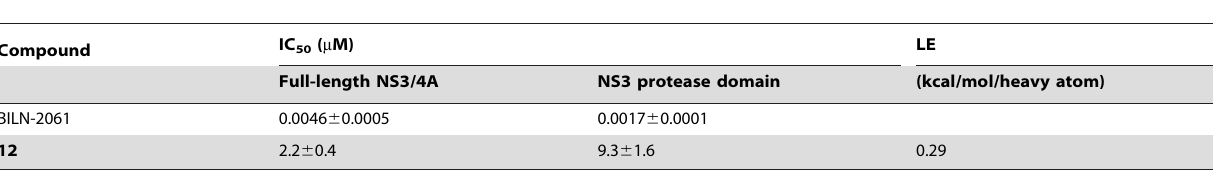
Table 2. Comparison of the inhibitory activities of 12 with a control.